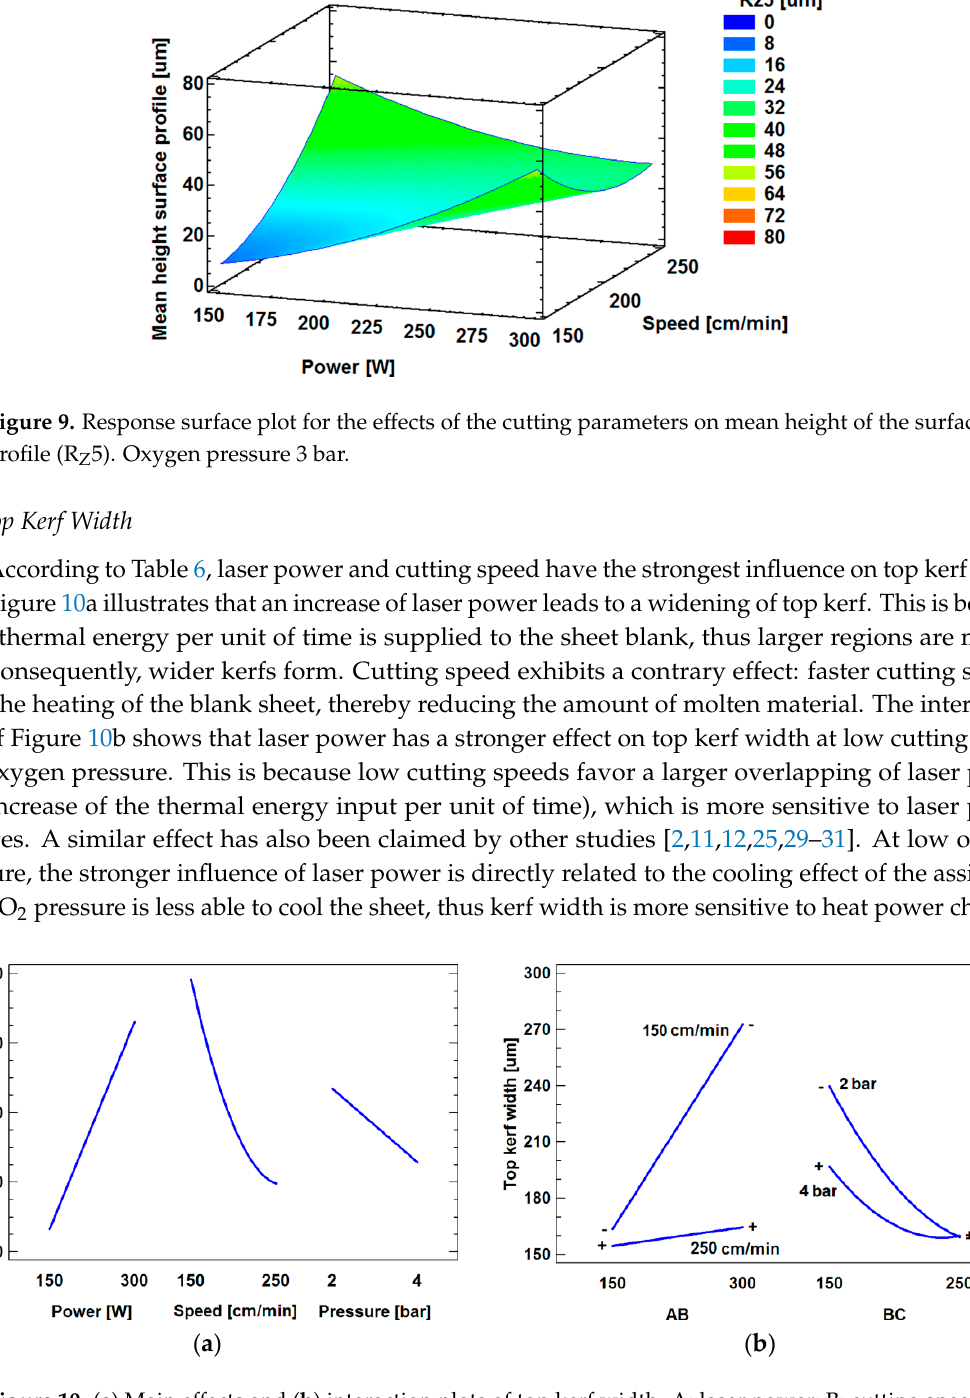
Figure 10. ( a ) Main effects and ( b ) interaction plots of top kerf width. A: laser power; B: cutting speed; C: oxygen pressure. Polynomial trendlines have been used to fit perpendicularity tolerance data.